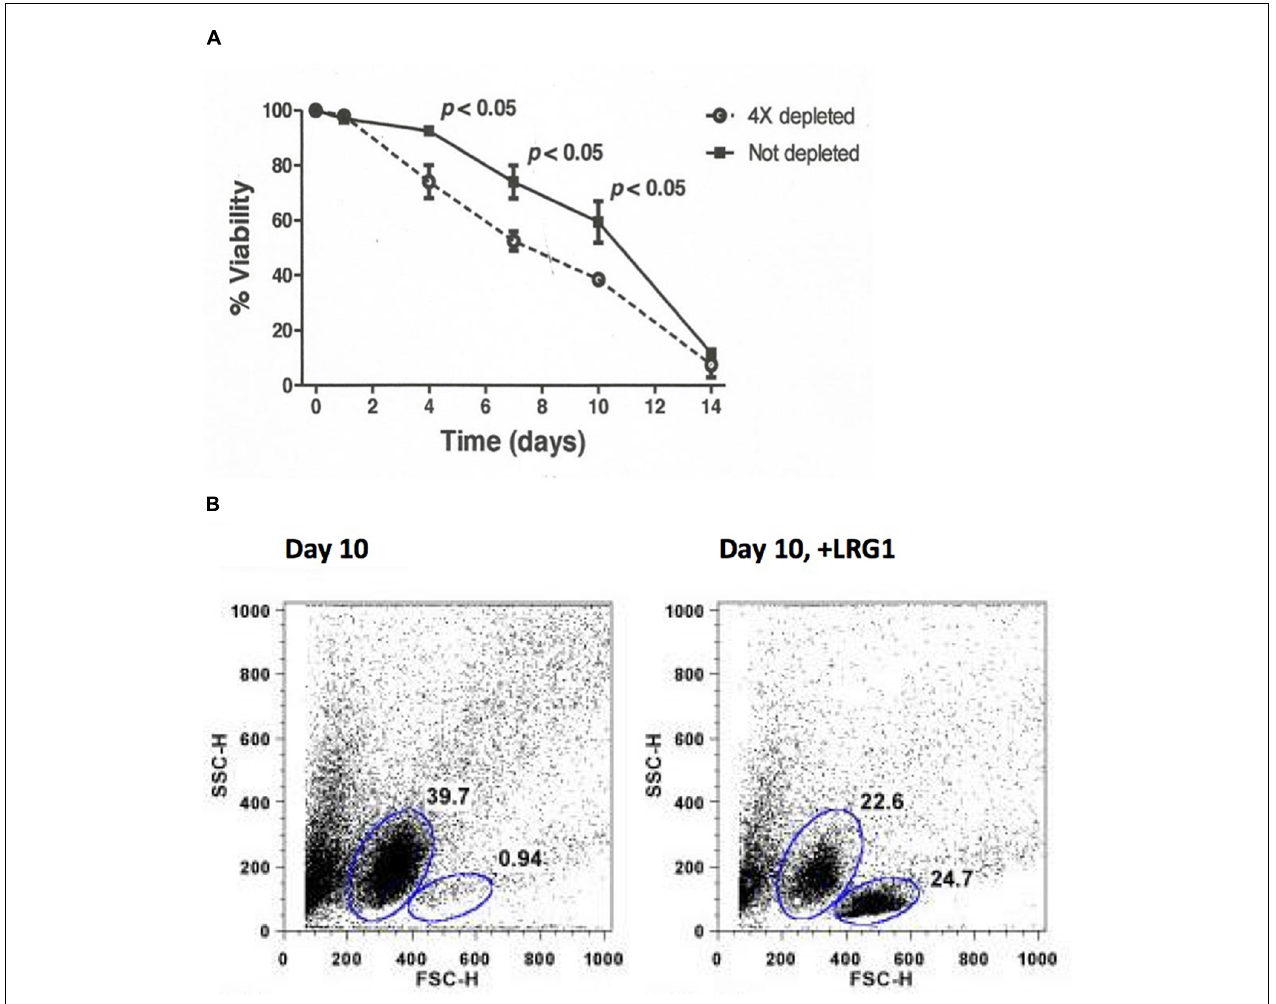
FIGURE 4 | Depletion of LRG1 from culture media causes human lymphocytes to transition through an apoptotic phase faster than when LRG1 is present. (A) Depletion of LRG1 from culture media causes human lymphocytes to die faster. Dulbecco’s modified Eagle’s medium containing 10% fetal bovine serum was depleted of bovine LRG1 by adsorption through Cyt c -Sepharose 4B. Lymphocytes from three human subjects were cultured separately and viability was assessed by trypan blue exclusion. Averaged data were analyzed by two-sided Student’s t -test for paired comparisons. (B) Flow cytometry analysis (forward scatter versus side scatter) of cultured lymphocytes from one donor at day 10 showing 39.7% of the cells are apoptotic and only 0.94% are viable. Addition of human LRG1 has an anti-apoptotic effect (24.7% viable in this case) (adapted from Codina et al.,